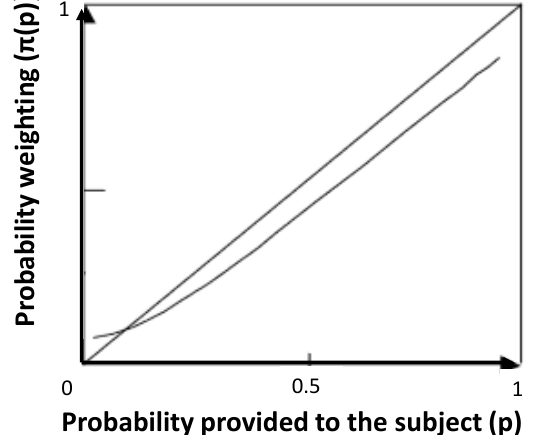
Figure 3. Probability transformation